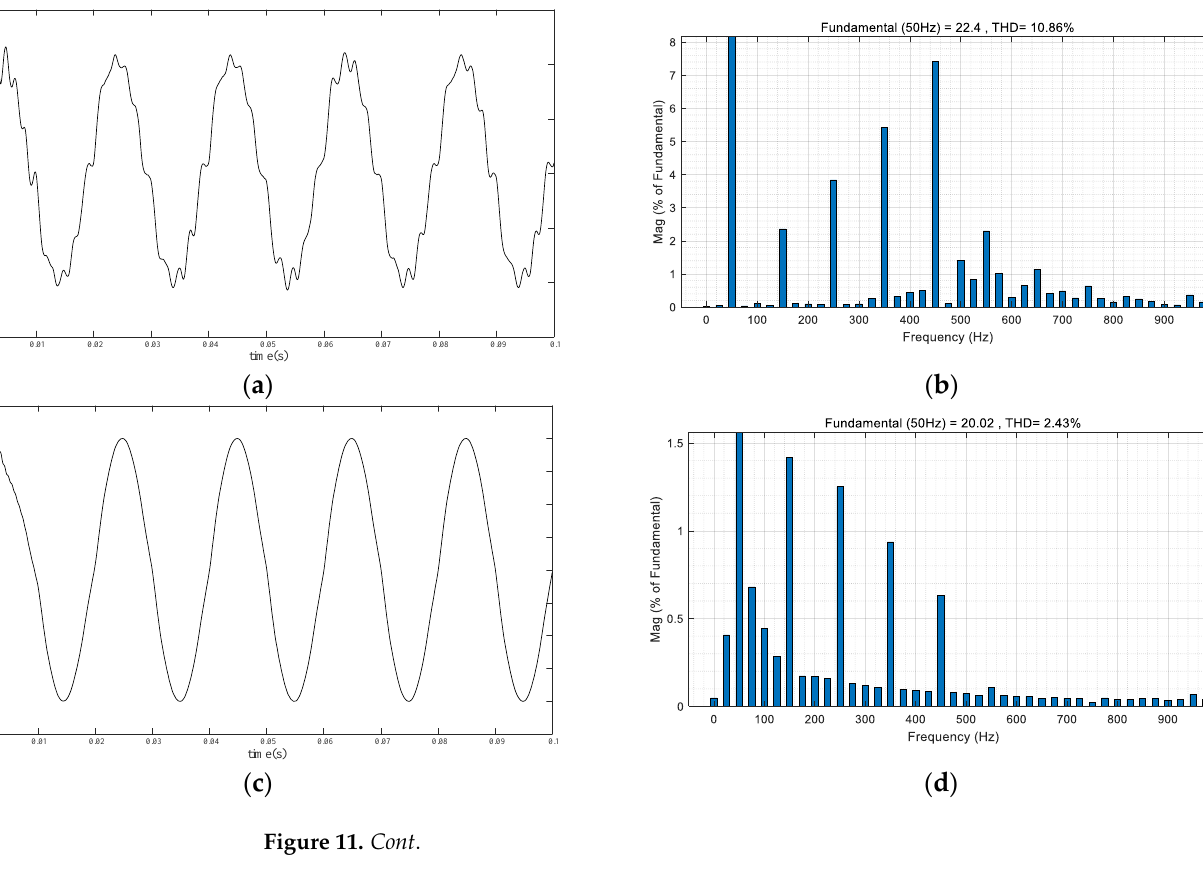
Table 4. THD analysis of grid-connected current under weak grid conditions.